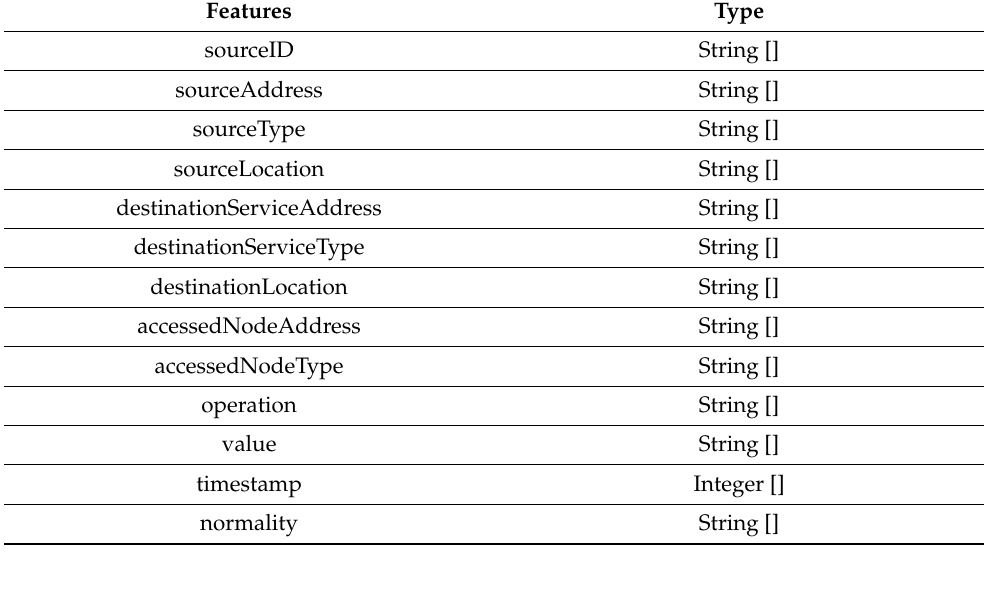
Table 2. DS2OS dataset features.